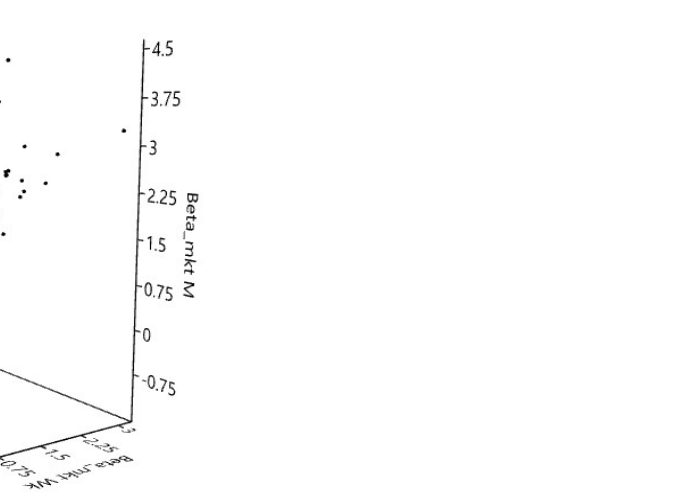
Figure 1. Scatterplot (3-D) of betas derived from daily, weekly and monthly returns (2000–2021).